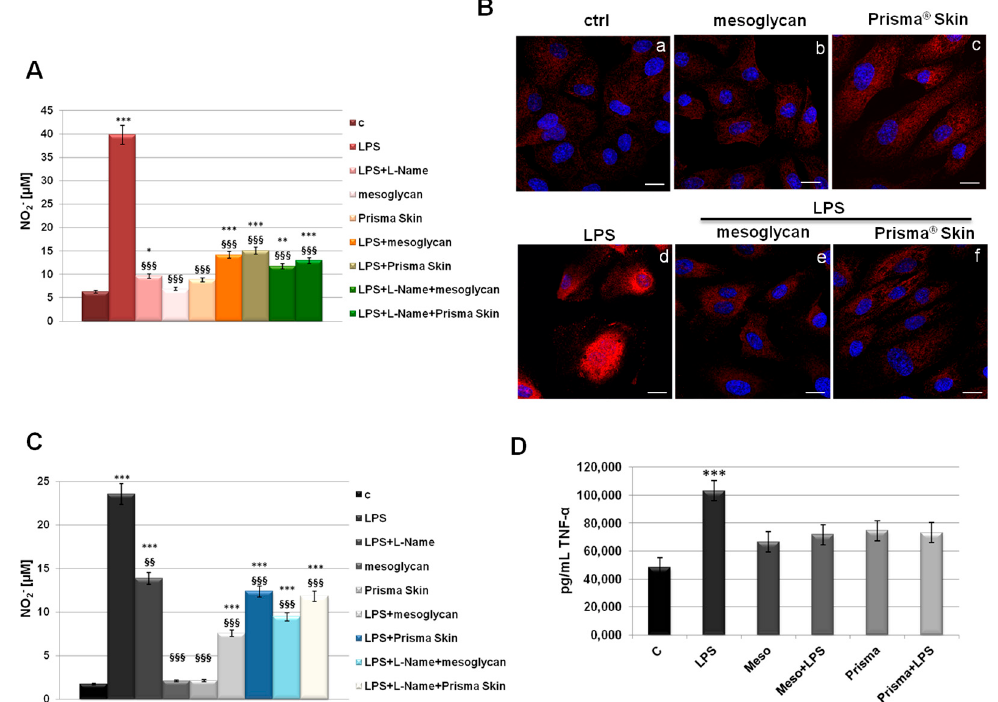
Figure 6. ( A ) NO (nitric oxide) release detected as [NO 2 − ] µ M by Griess reaction in presence of LPS (10 µ g/mL) for 24 h, with or without L-Name (100 µ M), mesoglycan and Prisma ® Skin 0.3 mg/mL; ( B ) HUVEC cells were treated with LPS (10 µ g/mL) for 24 h and co-exposed or not with sodium mesoglycan and Prisma ® Skin 0.3 mg/mL and nuclear translocation of NF- κ B p65 subunit was detected using immunofluorescence assay at confocal microscopy. Nuclei were stained with DAPI. Magnification 63 × 1.4 NA. Bar = 10 µ m. All the results are representative of 3 experiments with similar results; ( C ) NO release detected on SC cells in presence of LPS (10 µ g/mL) for 24 h, with or without L-Name (100 µ M), mesoglycan and Prisma ® Skin 0.3 mg/mL. As for HUVEC cells, data derive from the mean of three independent experiments showing similar results and have been analyzed using Student’s t -test, assuming a two-tailed distribution and unequal variance. * p < 0.05; ** p < 0.01; *** p < 0.001 for all treatments vs. untreated cells. §§ p < 0.01; §§§ p < 0.001 for all treatments vs. LPS-treated cells; ( D ) TNF- α production was measured in the supernatants of SC cells by ELISA kit. Cells were Student’s t -test, assuming a two-tailed distribution and unequal variance. *** p <